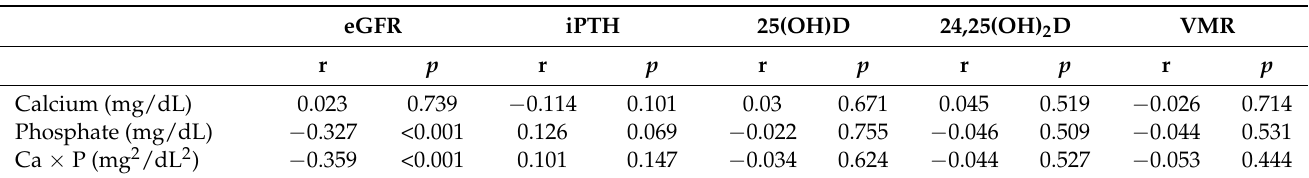
Table A1. Correlations of calcium, phosphate and calcium–phosphate product with eGFR, iPTH and vitamin D biomarkers.